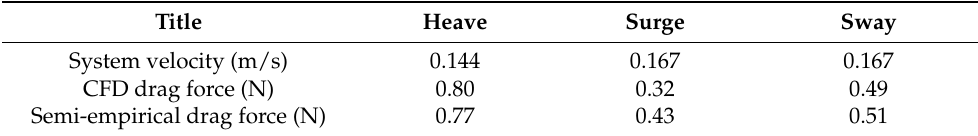
Table 8. Drag forces from CFD and semi-empirical